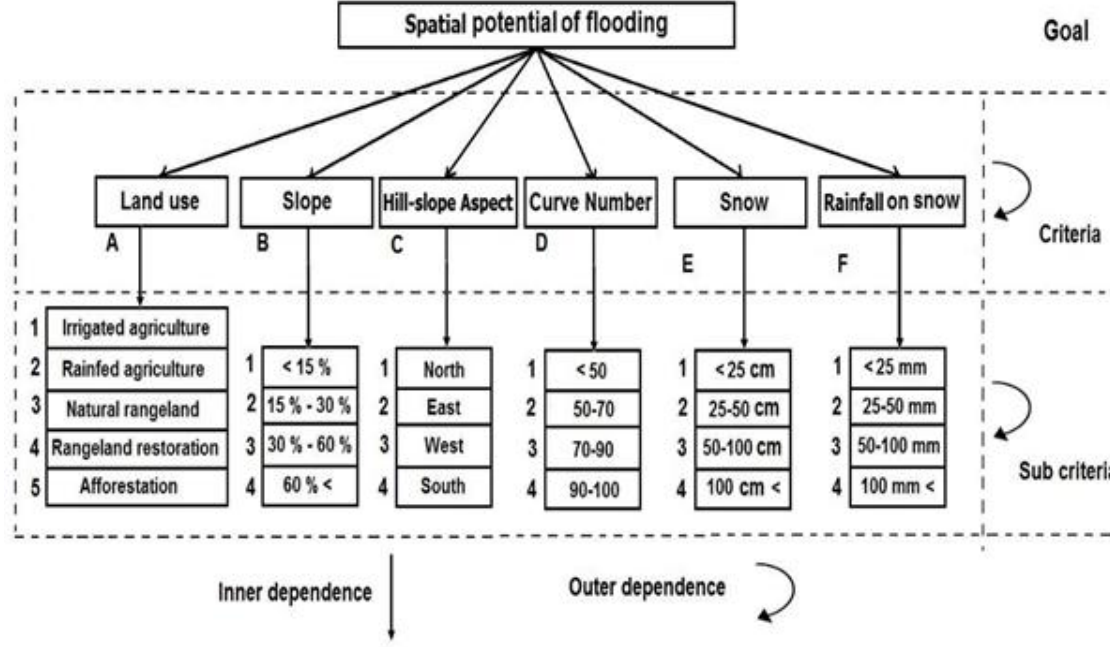
Fig. 4: The network models of the criteria and sub-criteria to estimate the spatial potential of flooding based on the